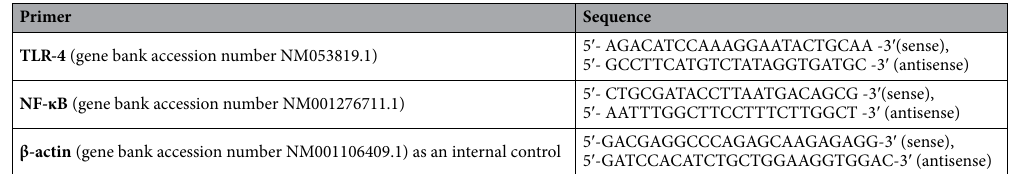
Table 3. Primer sequences used for the RT-PCR step. TLR-4, toll like receptor-4; NF-κB, nuclear factor-kB.